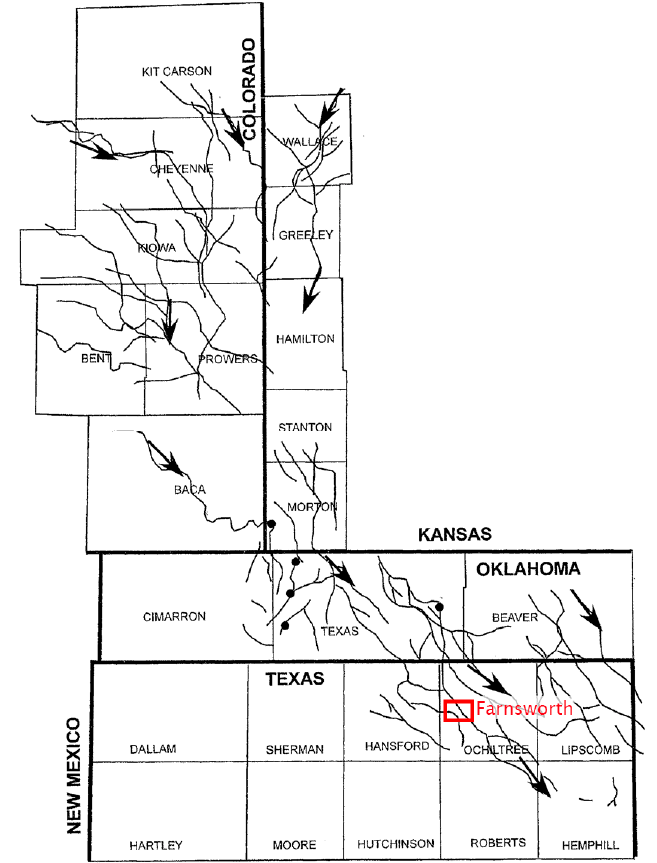
Figure 11. Sediment dispersal systems for late Morrowan deposition (modified from Puckette et al., 2008).